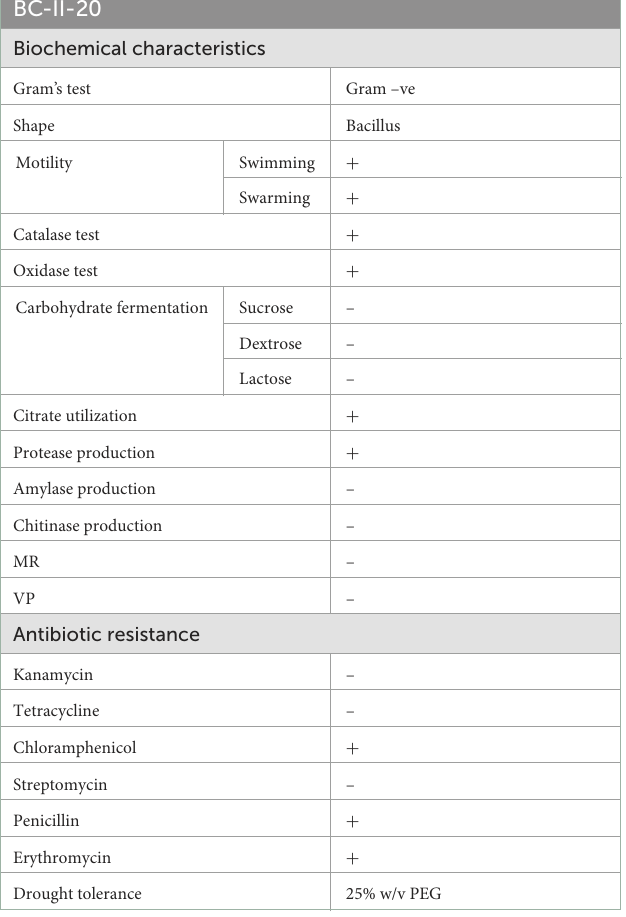
TABLE 1 Biochemical characteristics, antibiogram profile and drought stress tolerance of the isolate BC-II-20. BC-II-20